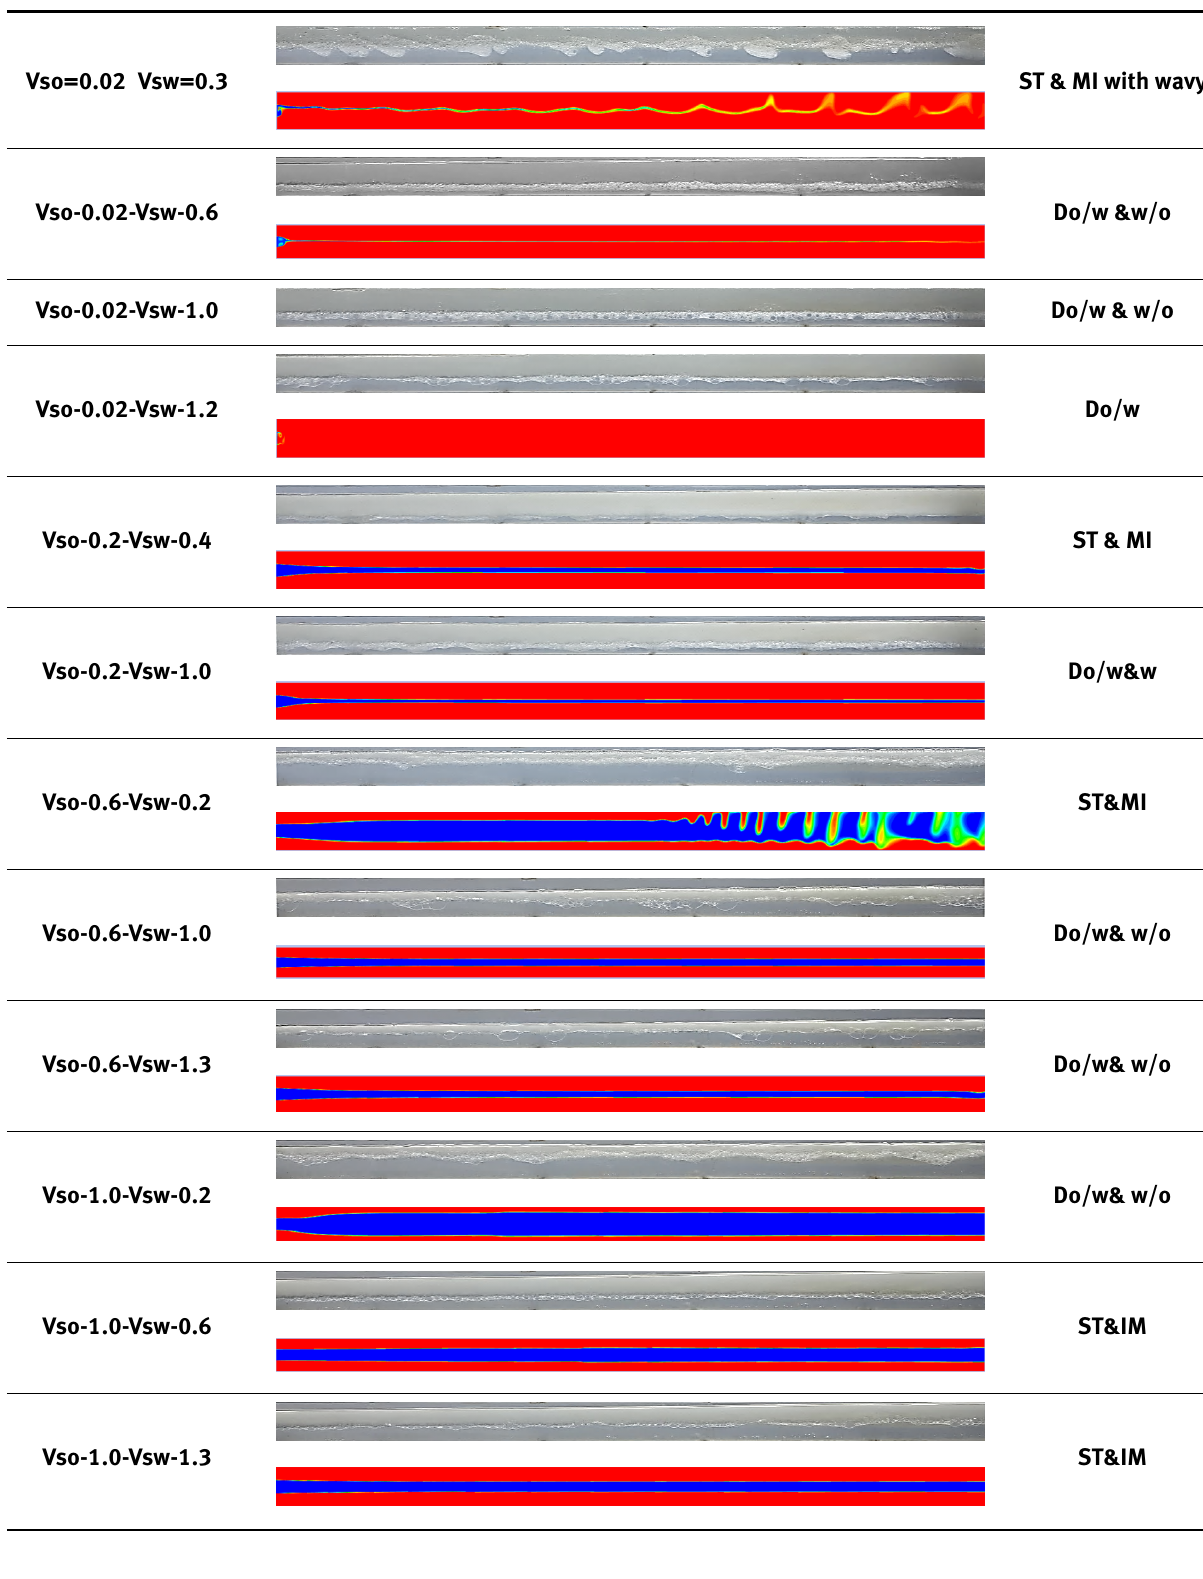
Table 19: Inter the kerosene from the middle for two-phase flow pattern for (L = 3 m, H = 5 cm)